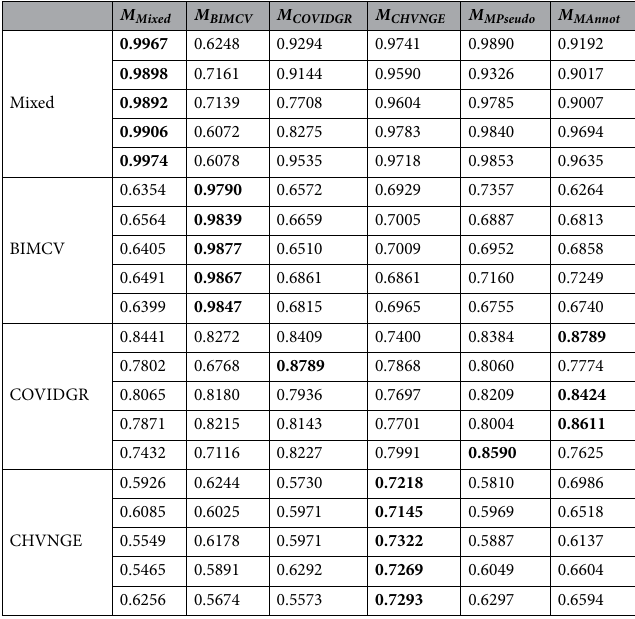
Table 5. Model AUC for each dataset and cross validation fold. Bold indicates the highest AUC per dataset and fold.